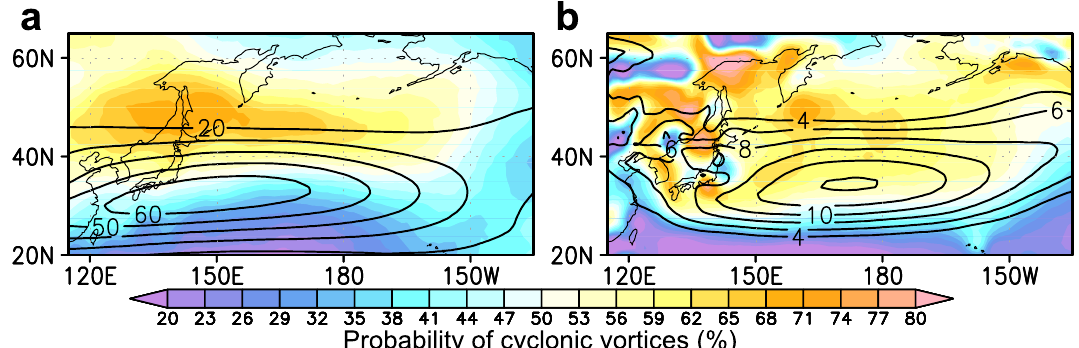
Figure 1. Probability of cyclonic and anticyclonic vortices. a–b , Climatological probability of cyclonic vortices (colors; with positive curvature) at 300-hPa ( a ) and 850-hPa ( b ) over the midwinter (24Jan) North Pacific. The probability of anticyclonic vortices can be obtained as the local residual. Black contours indicate climatological- mean U300 ( a ) and U850 ( b )